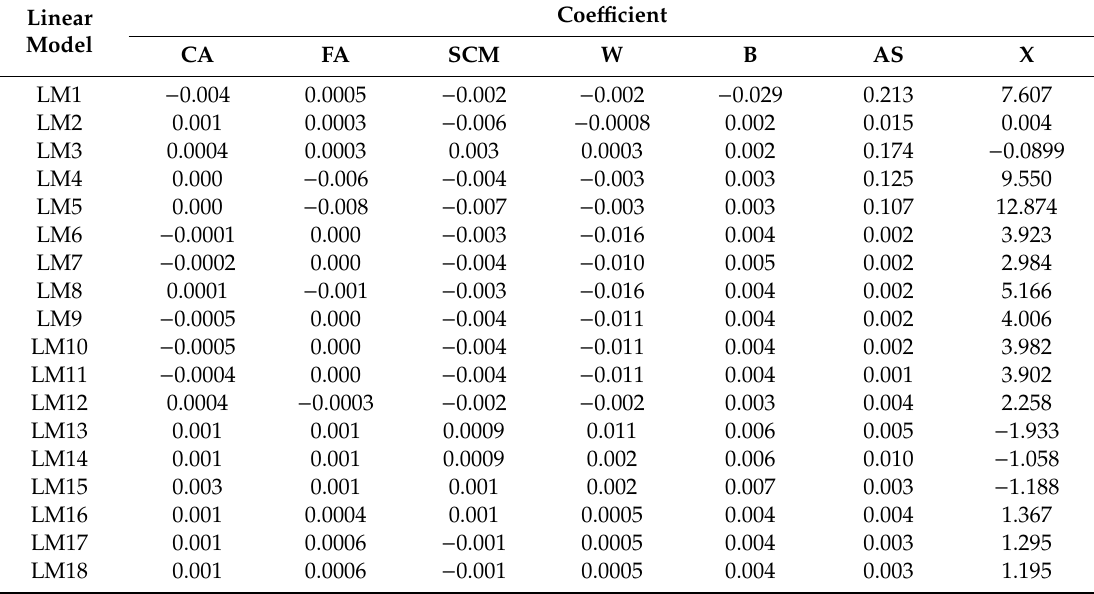
Table A2. Input coe ffi cients of M5p for TS estimation.